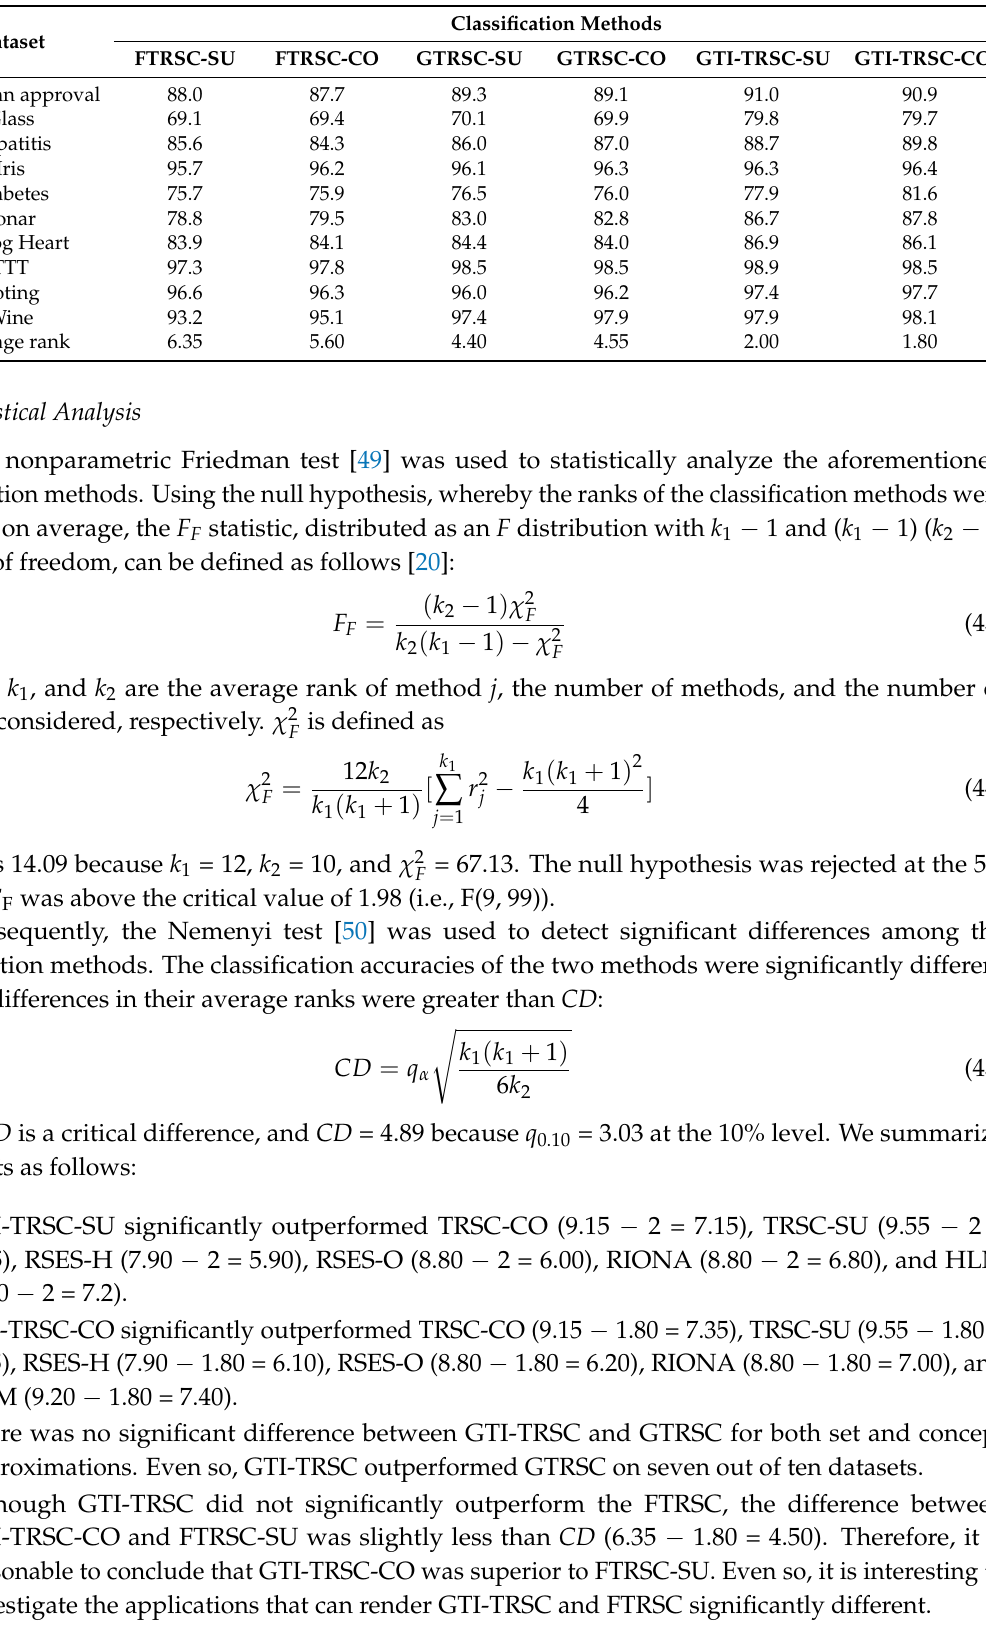
Classification accuracy of TRSC variants. FTRSC: Flow-based TRSC; GTRSC: Grey-tolerance-rough- set-based